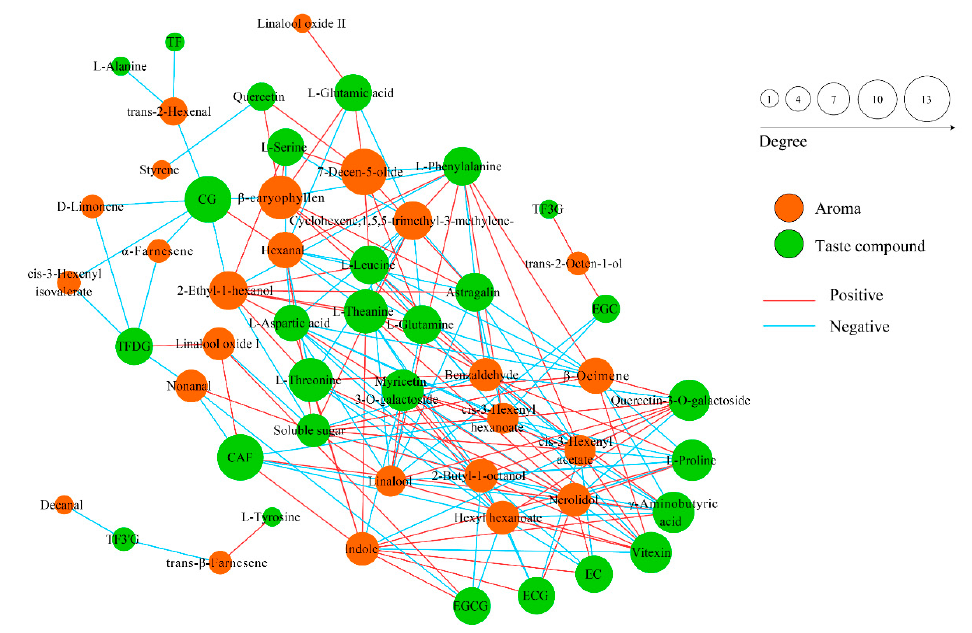
Figure 7. Correlation analysis of aroma components and taste components of two groups of oolong tea tea samples.